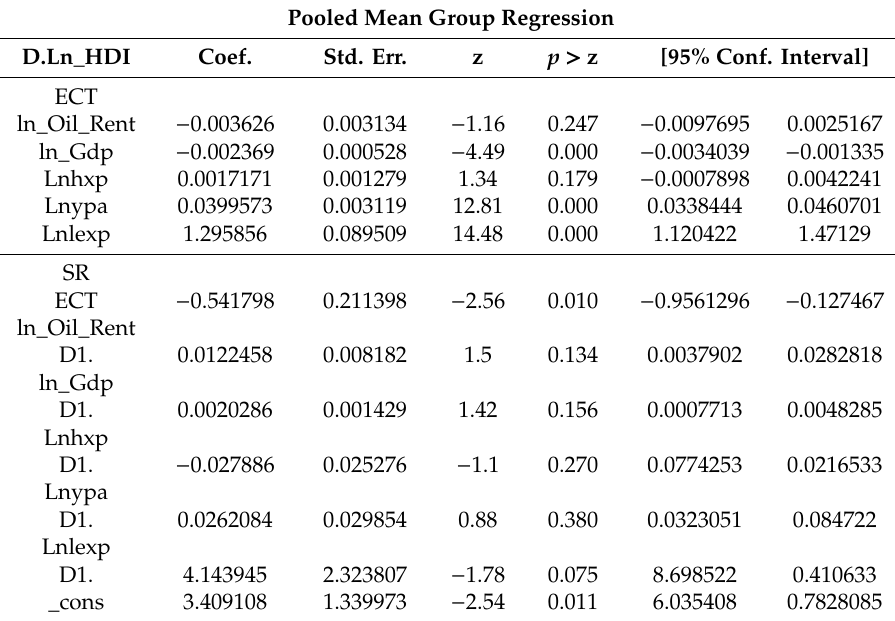
Table 7. Long run coe ffi cients of the PMG